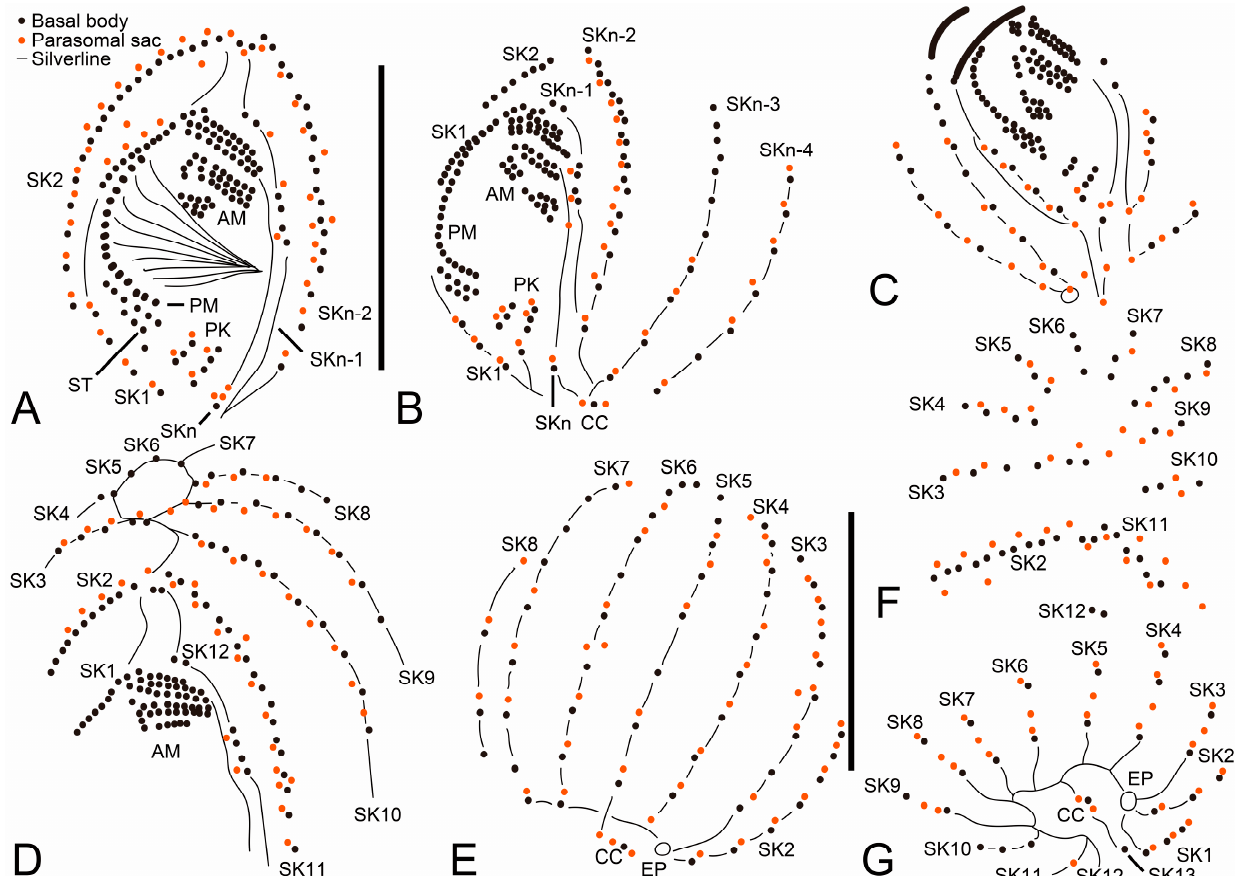
Figure 2. Cinetochilides minimus sp. nov. after wet silver nitrate impregnation. ( A – G ). Ventral ( A – D ), dorsal ( E ), apical ( F ), and posterior polar ( G ) view of typical specimens. AM, adoral membranelles; CC, caudal cilium; EP, excretory pore; PK, postoral kineties; PM, paroral membrane; SK, somatic kineties; ST, scutica. Scale bars: 10 µm. Table 1. Morphometric data on Cinetochilides minimus sp. nov.